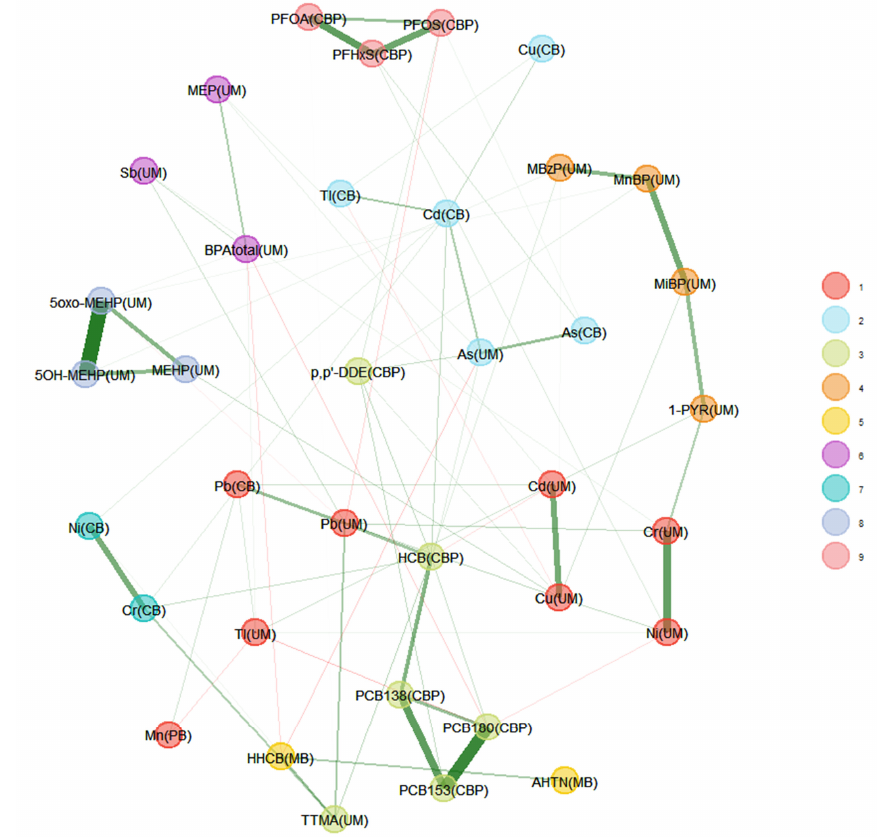
Figure 5. Weighted network for 3xG. The data were corrected for age, smoking, and BMI. Urinary markers were standardised for creatinine and lipid soluble blood markers were standardised for lipids. Matrices in which biomarkers are measured appear between brackets. Green lines represent a positive dependency between nodes (biomarkers) while red lines represent a negative depend- ency.